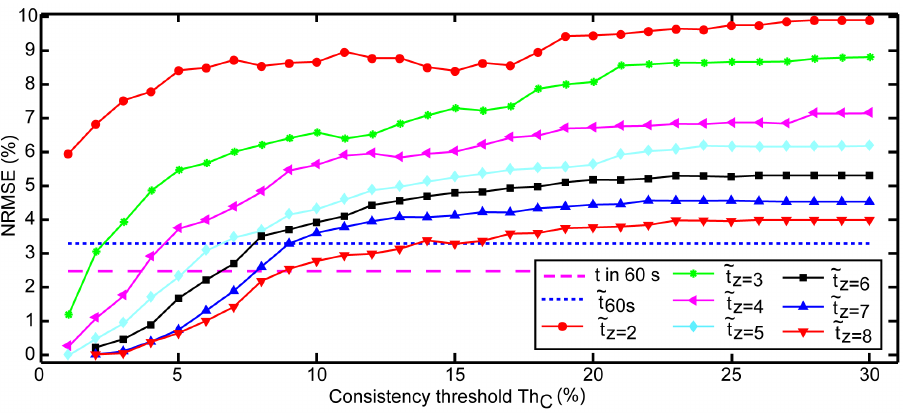
Figure 5. Plot of normalized root mean square error (NRMSE) against consistency threshold for different number of time intervals in a set. NRMSE decreased (accuracy improved) with tighter consistency thresholds and with increasing number of intervals in a set. At lower Th C and higher z there were fewer successfully completed cases (Figure 7) that contributed to the results.